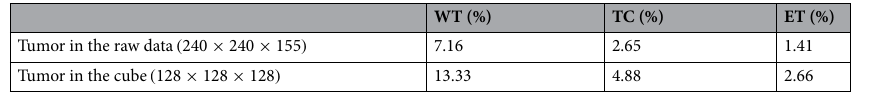
Table 3. The average percentages of the various types of tumors in the raw data with a size of 240 and cubes with a size of 128